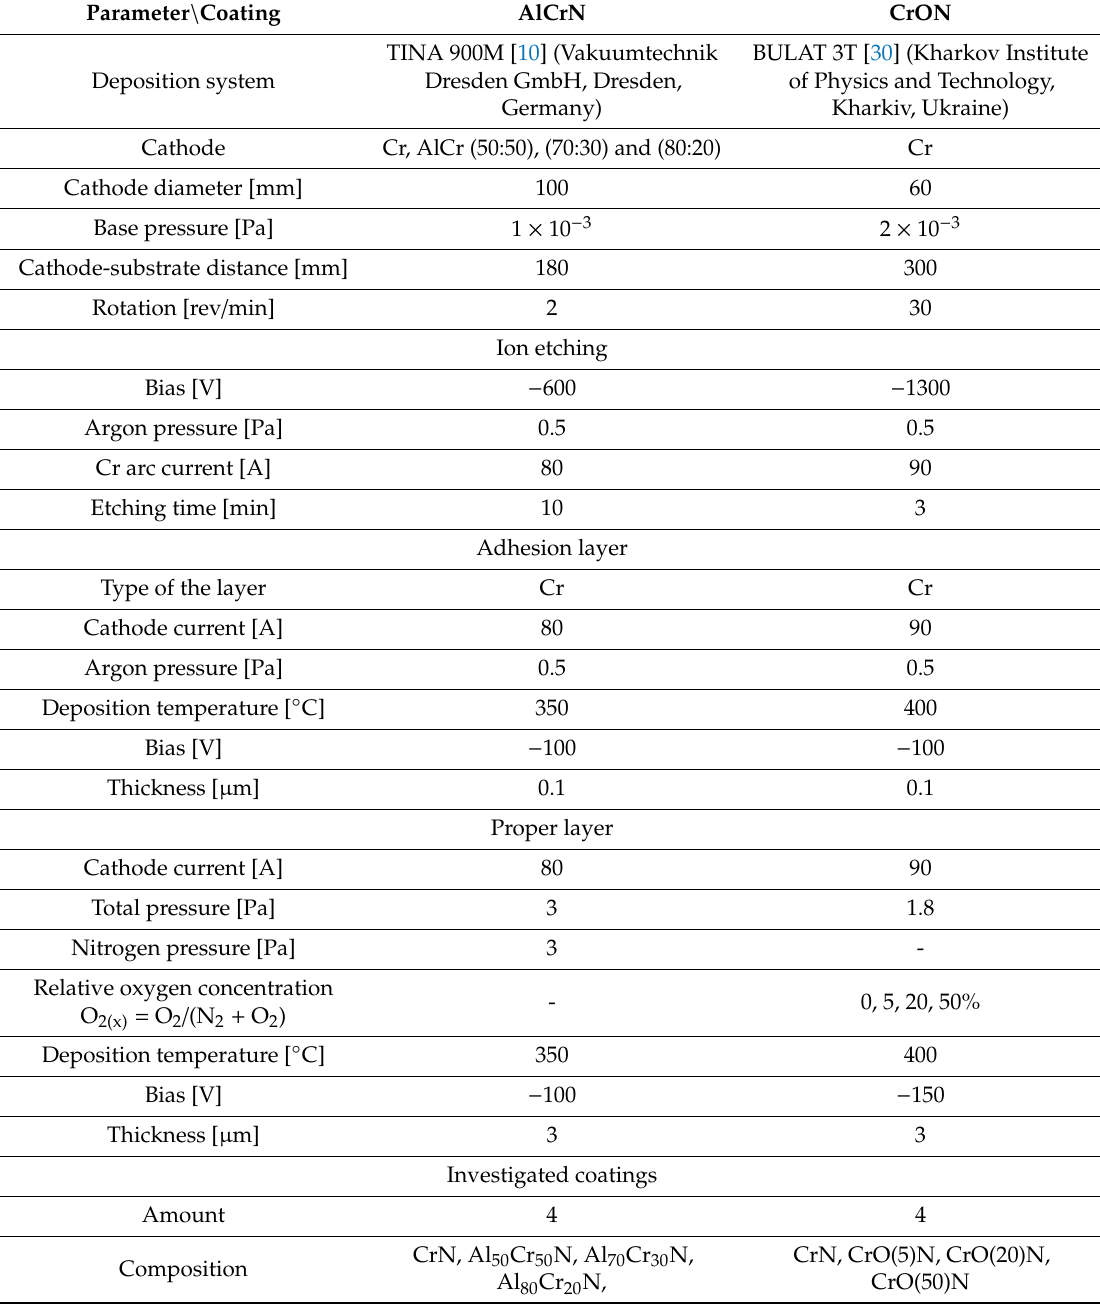
Table 1. The parameters of the multistep coating